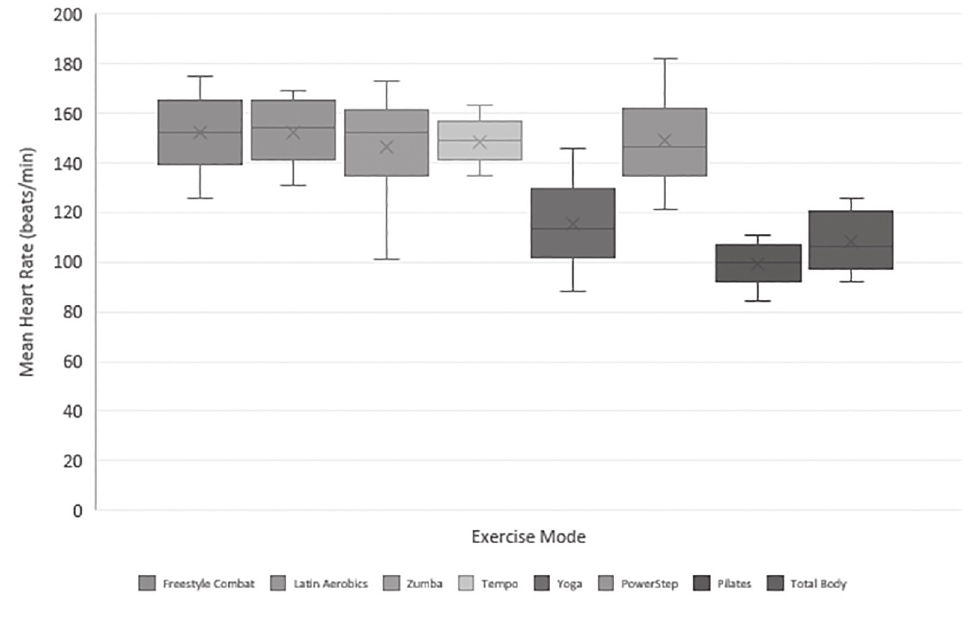
FIGURE 1. Participants’ Mean Heart Rate/Min by Exercise